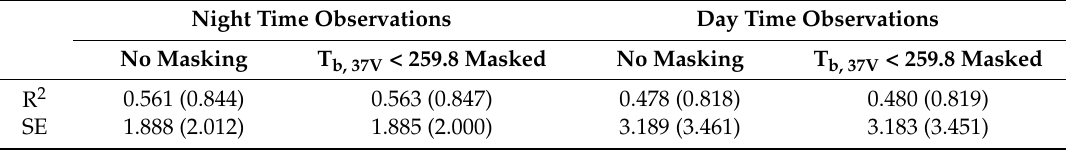
Table 1. Mean R 2 and SE over Australia that demonstrates the impact of a routinely applied masking procedure over our study area. Note that the statistics for the anomalies were presented first and those for the raw timeseries were presented within brackets.